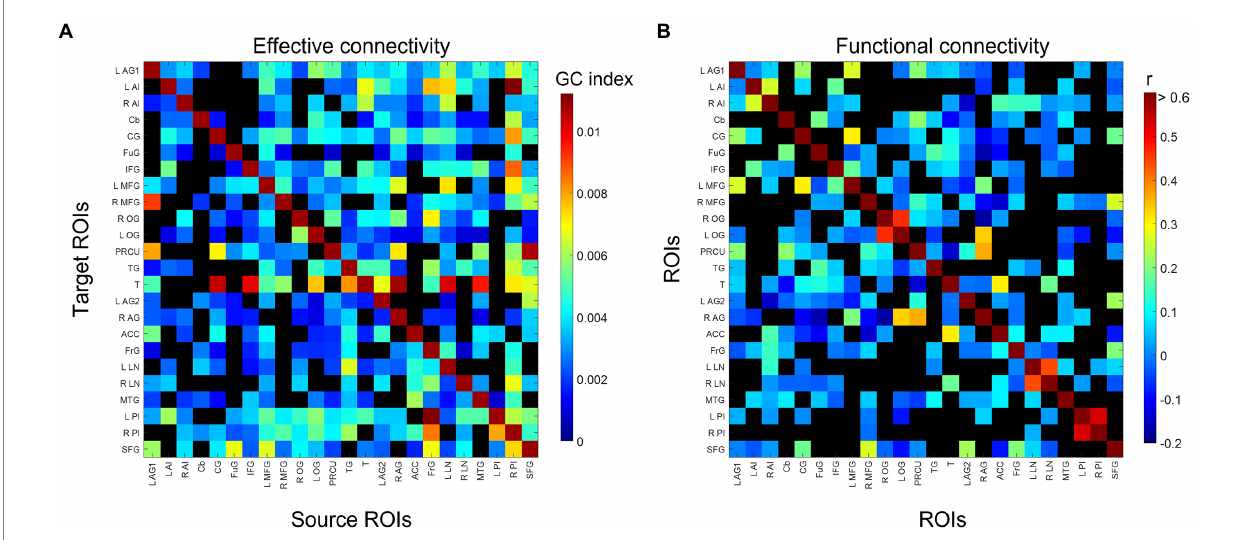
FIGURE 2 Identified group-consensus (A) EC (directed graph) and (B) FC (undirected graph) among 24 task-related ROIs for Stroop task fMRI. The connectivity is shown in black if it is not statistically significant. AG, angular gyrus; AI, anterior insula; Cb, cerebellum; CG, cingulate gyrus; FG, fusiform gyrus; IFG, inferior frontal gyrus; MTG, middle frontal gyrus; OG, occipital gyrus; P, precuneus; TG, temporal gyrus; T, thalamus; ACC, anterior cingulate cortex; FG, frontal gyrus; LN, lentiform nucleus; MTG, middle temporal gyrus; PI, posterior insula; SFG, superior frontal